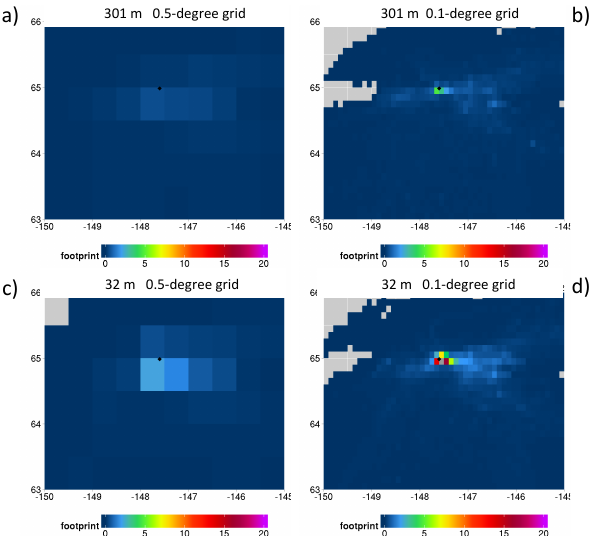
Figure 17. As in Fig. 16, except for the aggregate of 79 CARVE tower footprints on a 0.5 ◦ grid ( a and c ) and 0.1 ◦ grid ( b and d ). The 0.5 ◦ footprints are scaled by a factor of 1/25. Winds from all three domains of two-way nested WRF v3.4.1 runs are used.